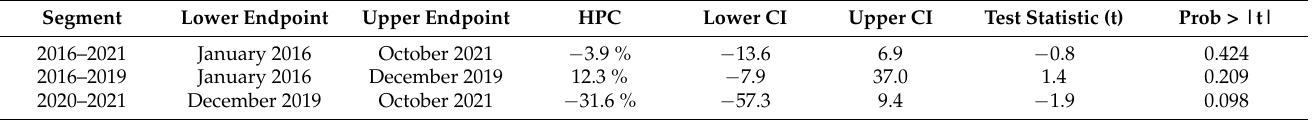
Table 1. Suicide trends during the study period with half-year per cent change